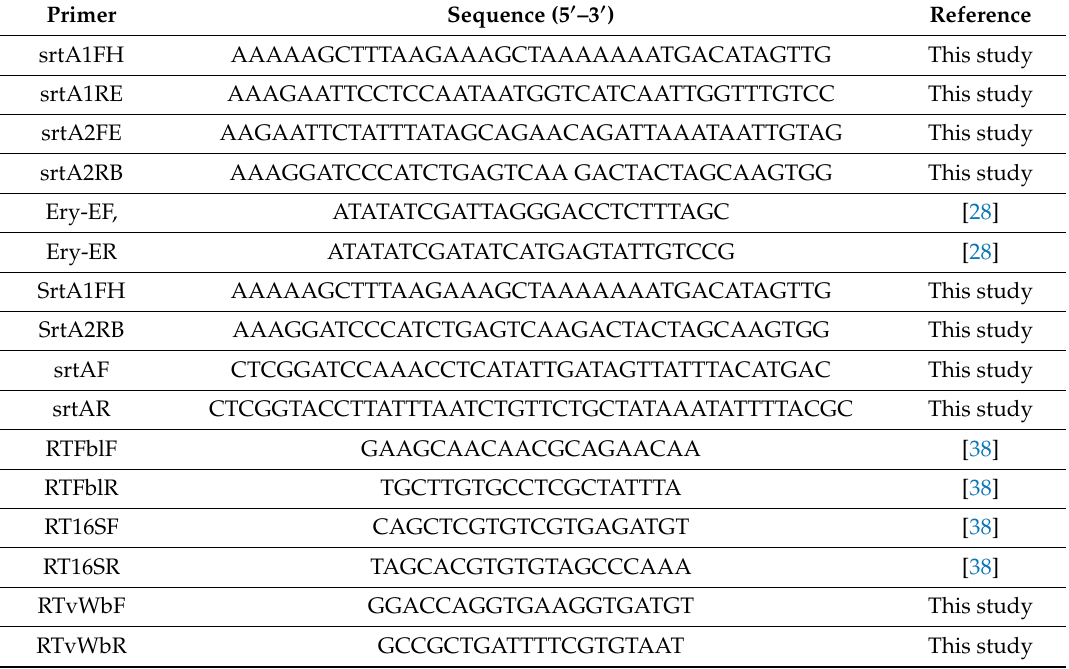
Table 2. Primer sequences used in this